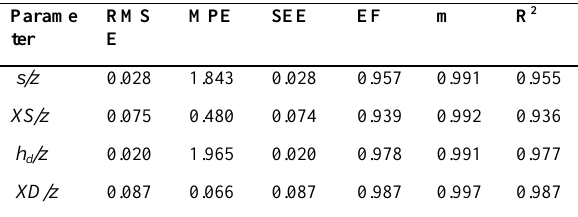
Table 5. Error functions from results suggested by equations (17)-(20) against experimental